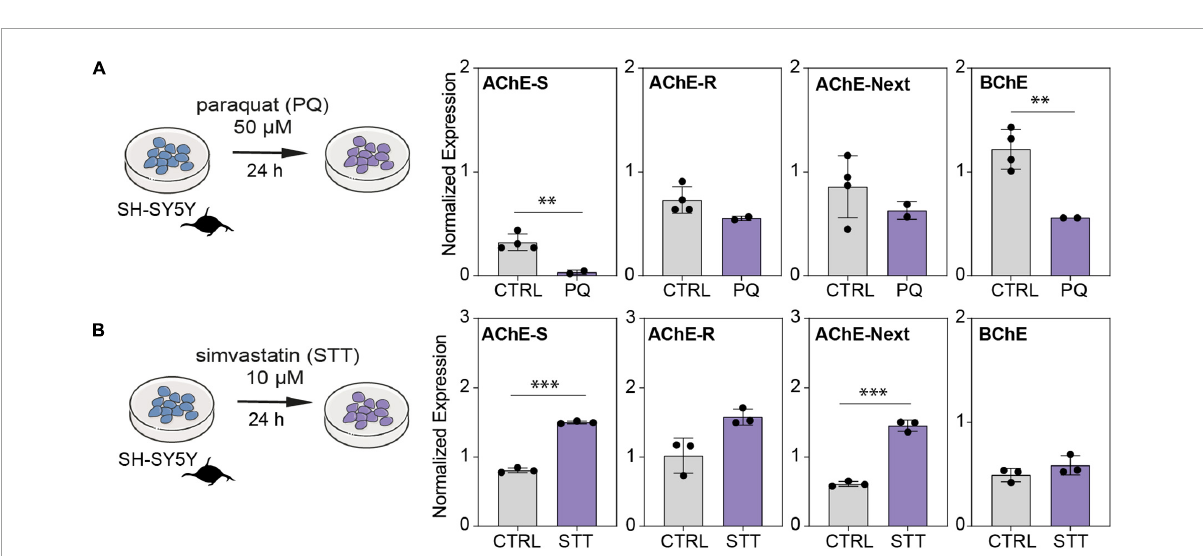
FIGURE6 Oxidative stress and antioxidant treatment shift cholinesterase mRNA levels inversely in neuroblastoma cells. (A) SH-SY5Y cells were exposed to the oxidative stress-inducing agent paraquat (PQ; 50 µ M) or to (B) antioxidant simvastatin (STT; 10 µ M) for 24 h. Note PQ-induced decreases in AChE-S ( p < 0.015), BChE ( p < 0.015), AChE-R ( p = 0.09), and AChE-Next ( p = 0.234), and STT-induced increase in AChE-S ( p < 0.0003), BChE ( p = 0.23), AChE-R ( p < 0.06), and AChE-Next ( p < 0.002). Normalized expression represents (cid:49)(cid:49) Cq, ∗ p < 0.05, ∗∗ p < 0.01, and ∗∗∗ p <